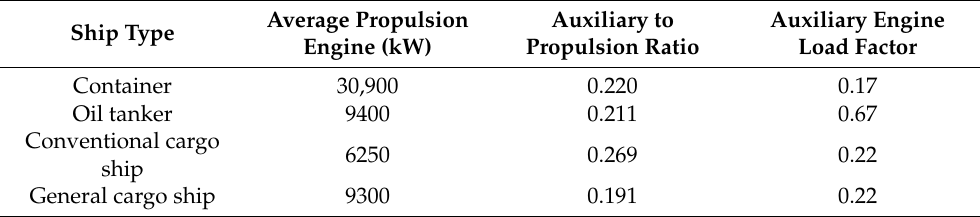
Table 6. Auxiliary engine power ratios and load factor in port during hoteling